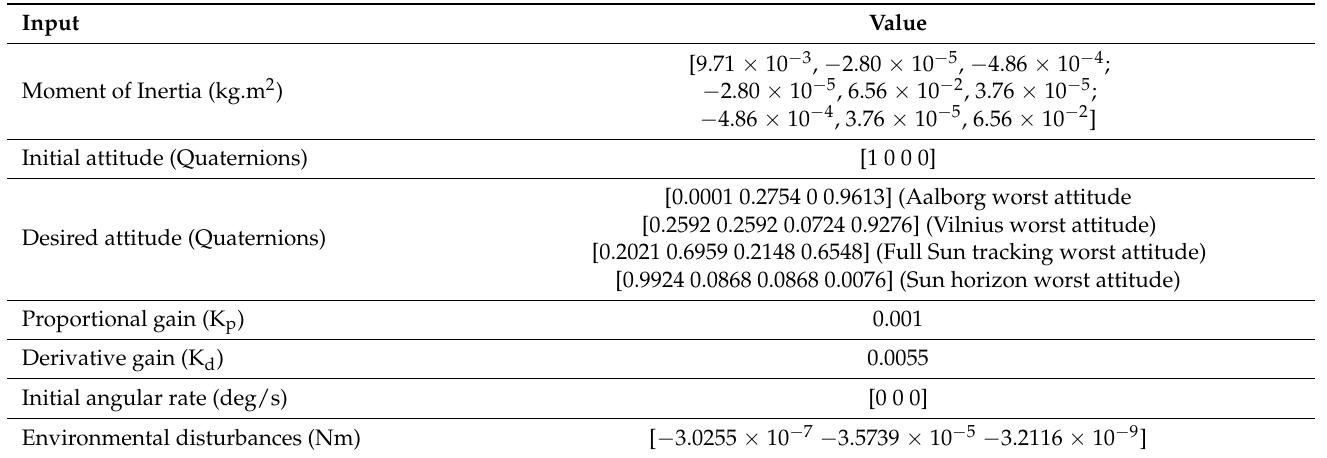
Figure 9. Detumbling in initial mode with 17.32 deg/s initial rate on each axis. Table 9. Input values used to run pointing